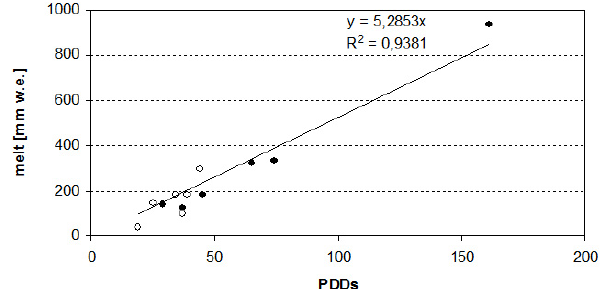
Fig. 2. Determination of the DDF using the correlation between Fig. 3: snow/ice melt and PDDs. The white dots are measured values during the summer months 2005/06. Data of the summer months 2004/05 and March 2006 (black dots) are provided by Iturraspe and Strelin (2005).